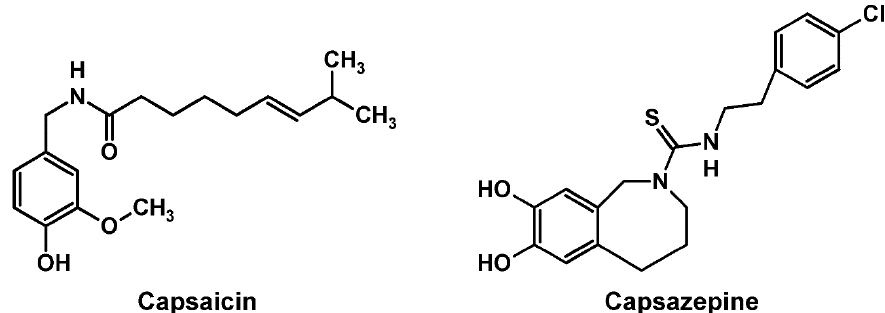
Figure 1. Structures of capsaicin and capsazepine.